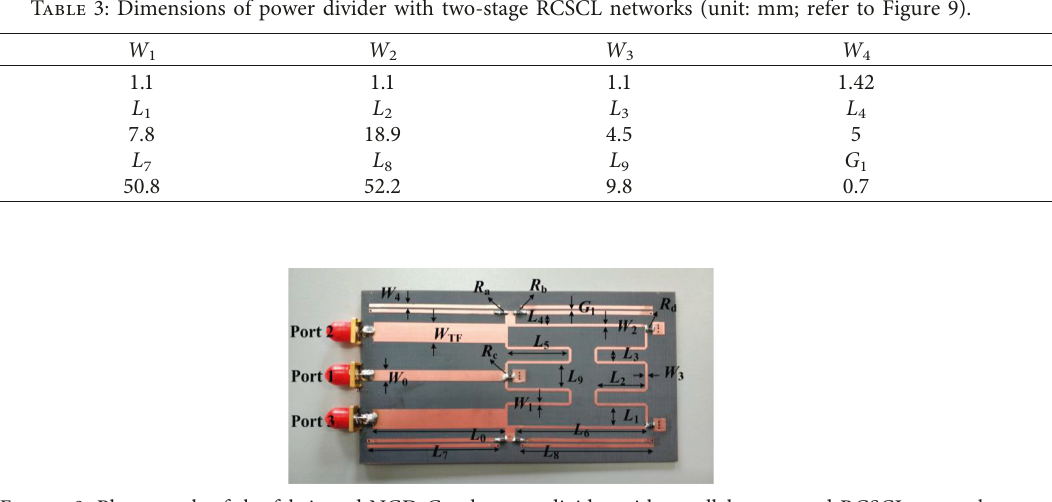
Figure 9: Photograph of the fabricated NGD Gysel power divider with parallel connected RCSCL networks.